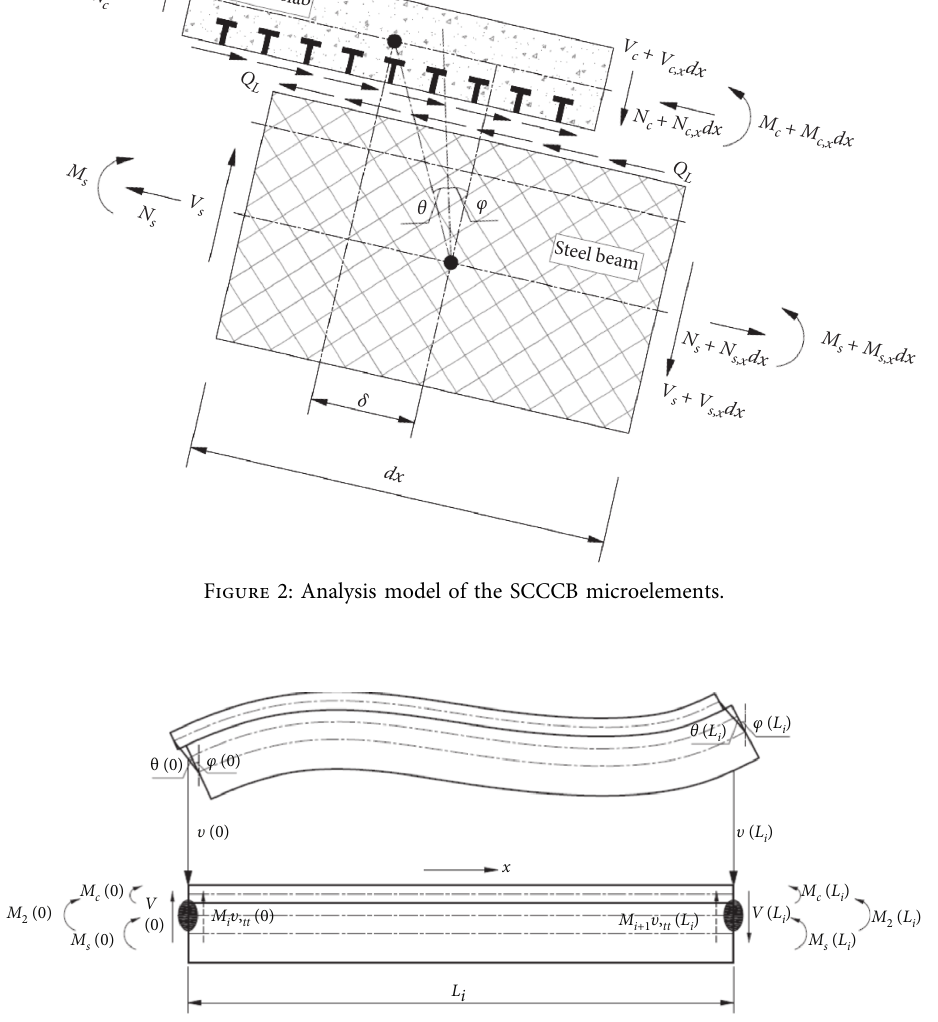
Figure 3: Six boundary conditions of the SCCCB element.